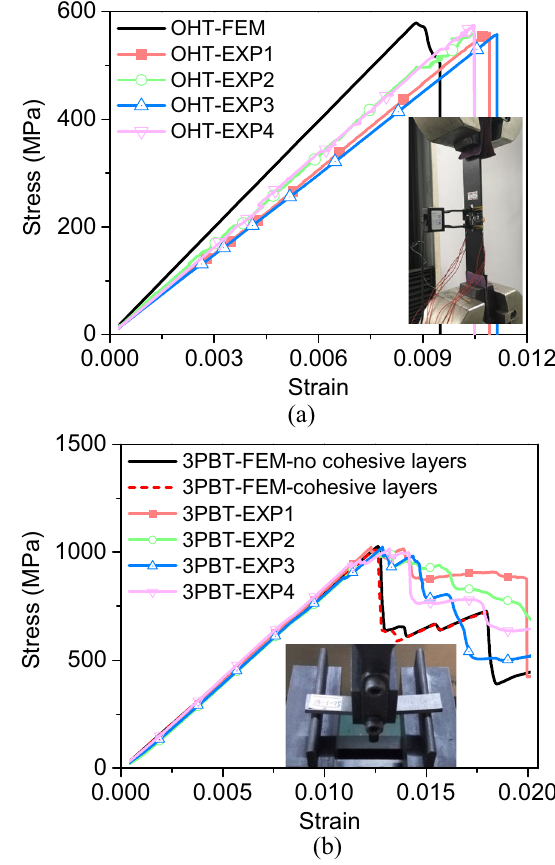
Figure 5 Result comparison of stress-strain curves between the tests and the FEM for: a open-hole tensile test; b three-point bending